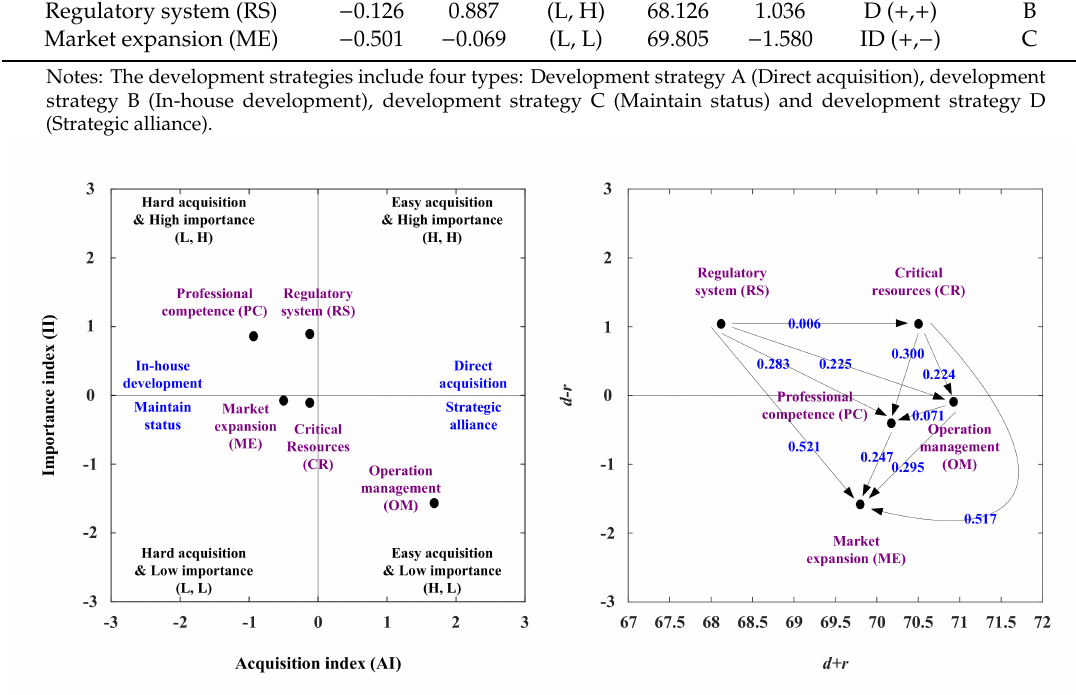
Figure 5. The AIA-NRM analysis for digital